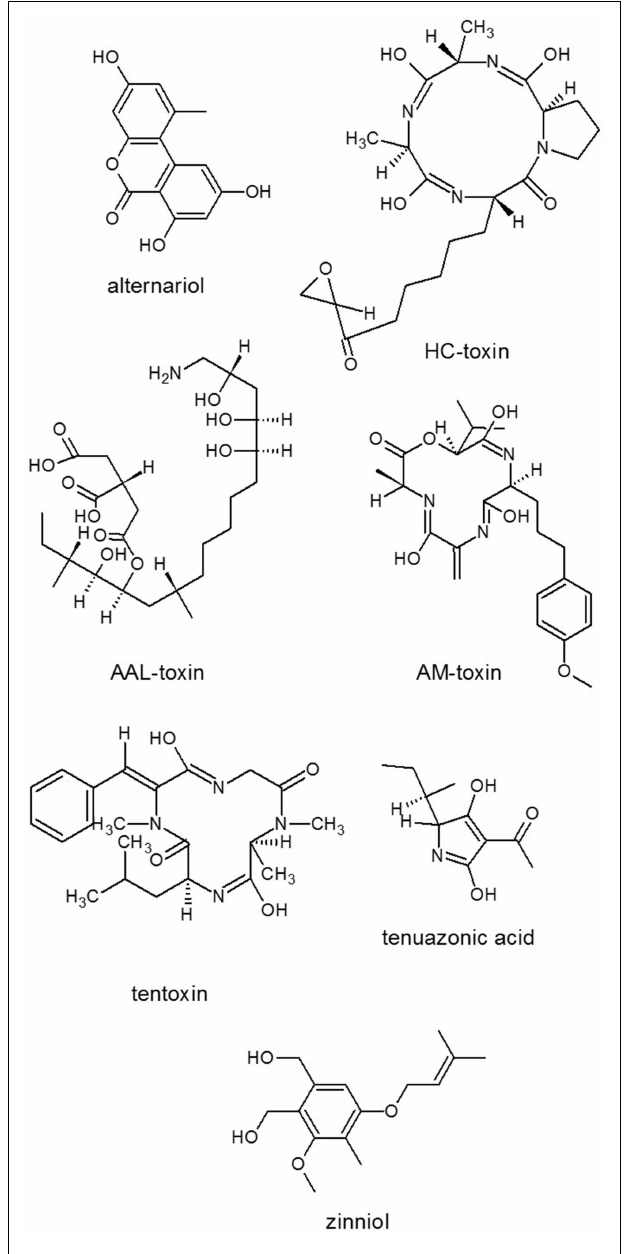
FIGURE 2 | Structures of representatives of Alternaria SMs. Source: National Center for Biotechnology Information. PubChem Compound Database (accessed Jun. 6, 2015) (Bolton et al.,